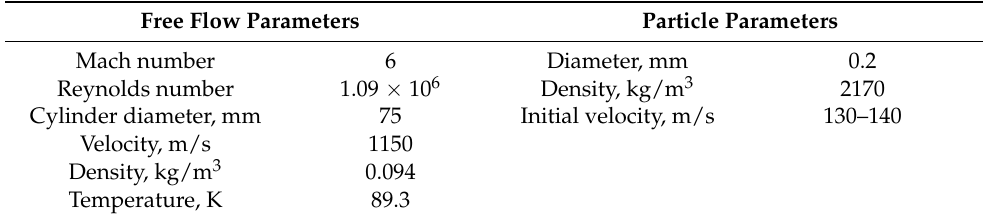
Table 1. Free flow and particle